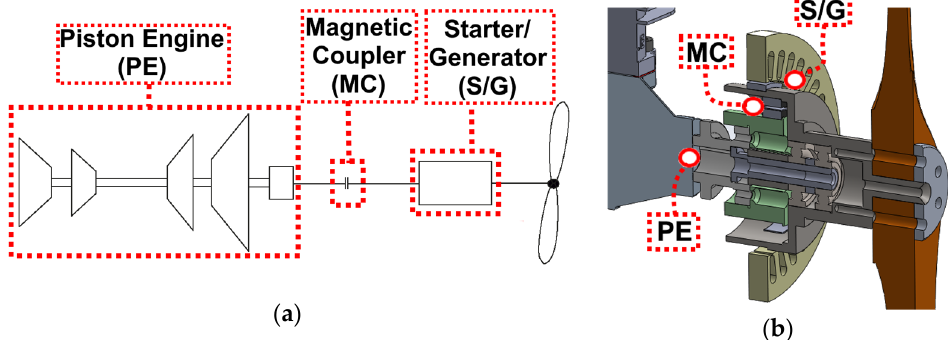
Figure 3. ( a ) Block diagram of the hybrid UAV; ( b ) 3D drawing of the proposed model. The novel MC is part of the customised Bearcat F85F model aircraft, which is a 60% hybrid by replacing the conventional 3W-140i PE [40] with the 3W-55XI PE and S/G of 6 kW and 4500 rpm. The MCs are prototyped, and the given dimensions are